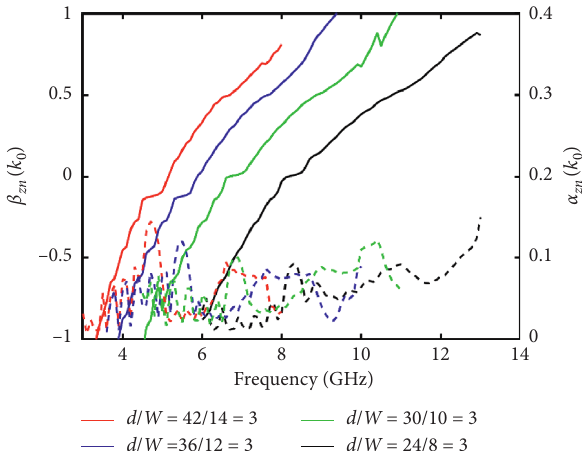
Figure 11: The normalized propagation constant of different parameters when d/ W � 3.